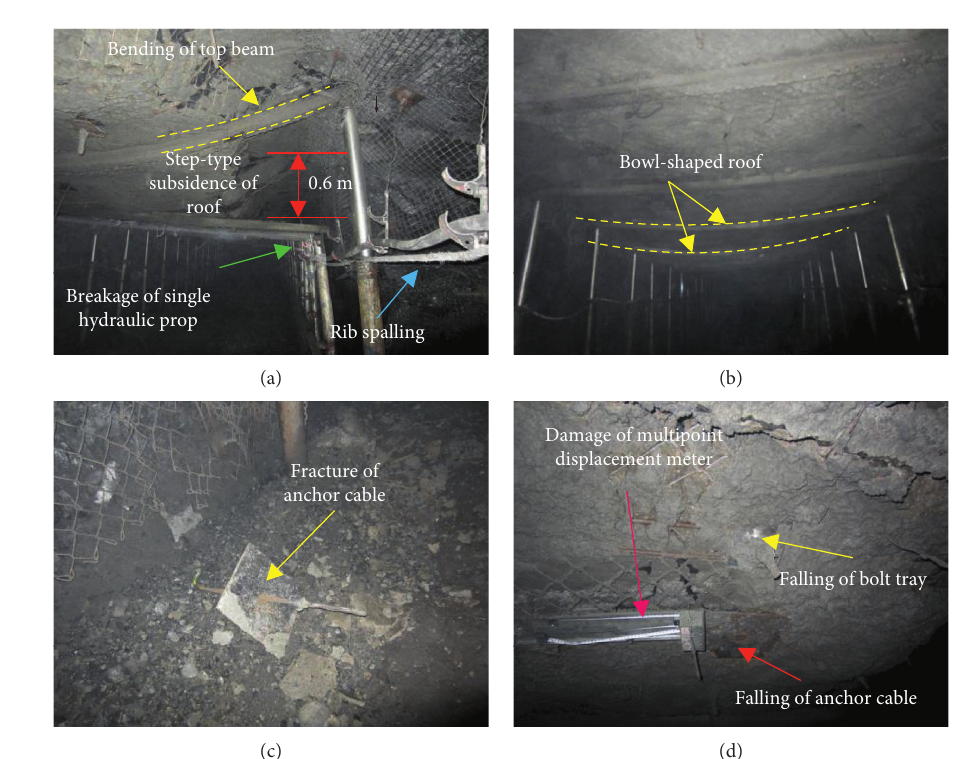
Figure 6: Deformation and failure forms of the surrounding rock of the